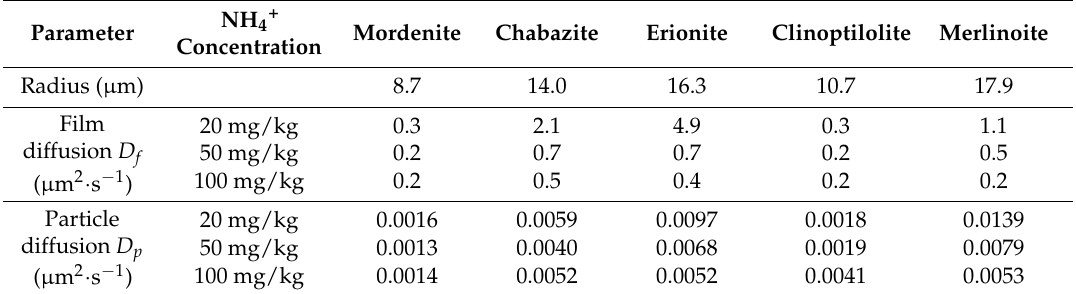
Table 4. Diffusion parameters of zeolites in different ammonium concentrations at 30 °C .